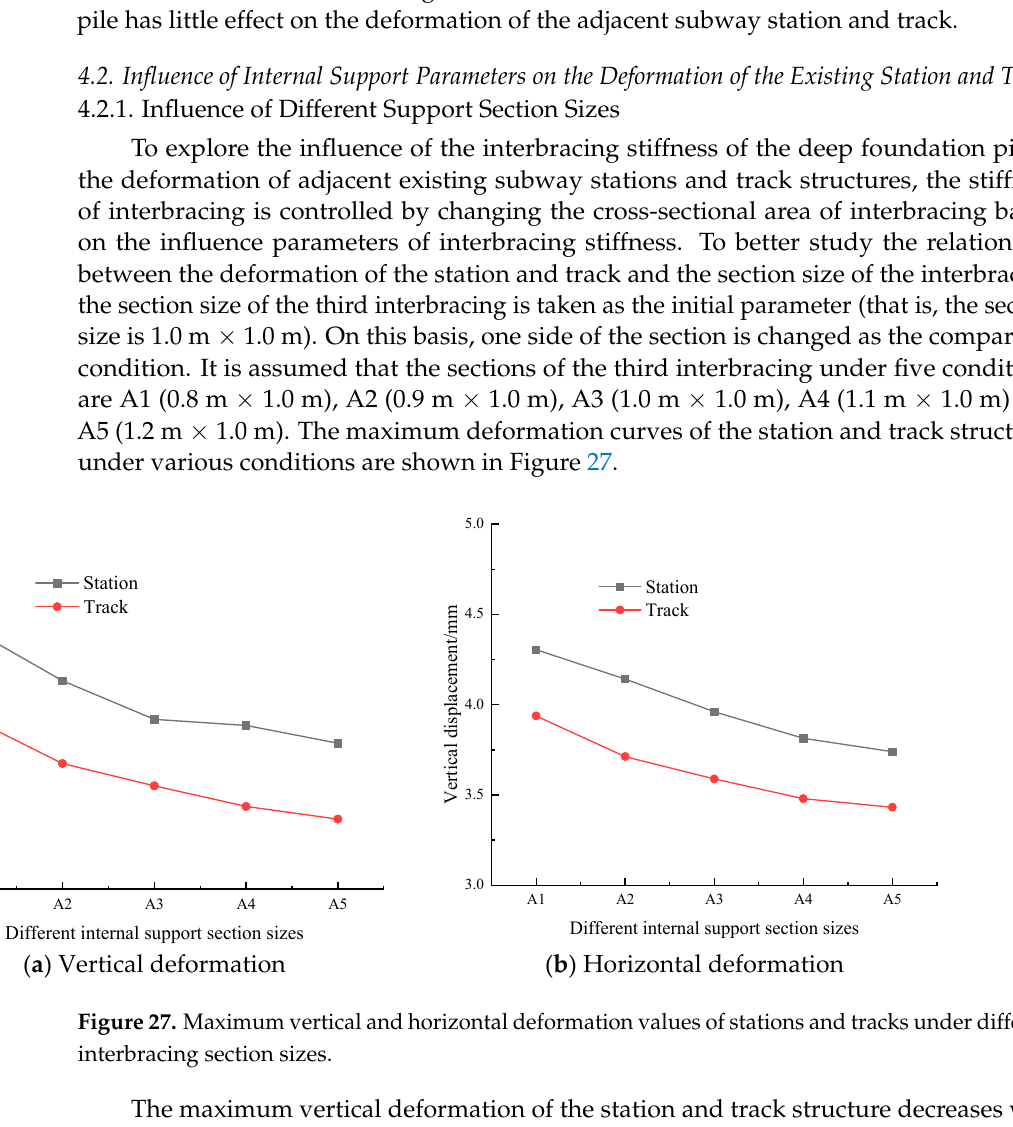
( b ) Horizontal deformation Figure 28. Maximum vertical and horizontal deformation values of stations and tracks under different numbers of interbracings. The maximum vertical deformation of the station and track structure decreases with the increase in the number of interbracing channels. When the interbracing of the foundation pit increases from four to seven, the deformation of the maximum vertical displacement of the station and track structure is no longer significantly increased. The maximum vertical deformation of the station is between 1.82 and 4.10 mm, and the maximum deformation of the track is between 1.64 and 3.51 mm. Compared with the deformation of the station and track under the influence of foundation pit construction of three interbracings and one anchor cable support system, when the foundation pit adopts